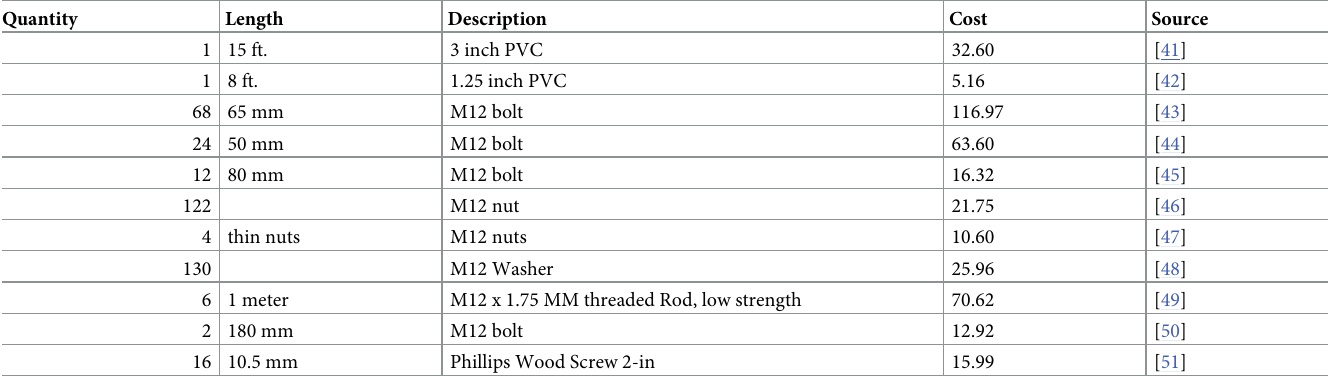
Table 1. Surgical table bill of materials for fasteners and PVC. Quantity